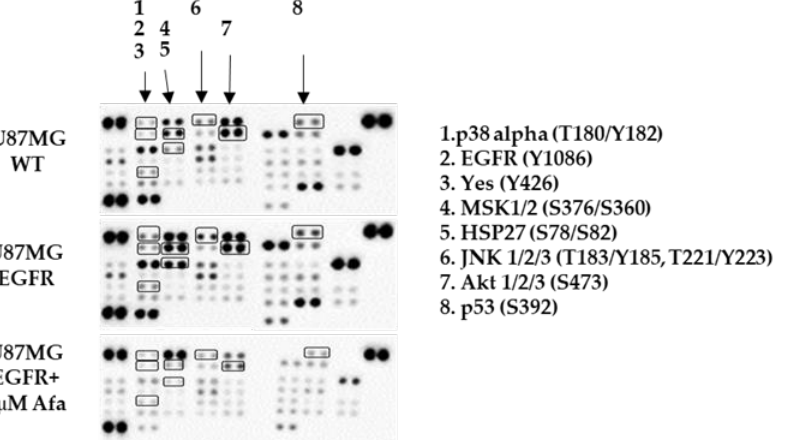
Figure 3. Phospho-kinase array evaluation of EGFR downstream effectors. A human phospho-kinase blot array of U87MG control (WT) cells, U87MG EGFR cells, and U87MG EGFR cells with afatinib (afa) treatment is shown. The kinases circled and numbered in the blots and either on the right of the image represent major signaling protein targets of EGFR activation. Table 1. The kinases with high fold phosphorylation levels in response to overexpression of EGFR that were decreased following afatinib treatment .